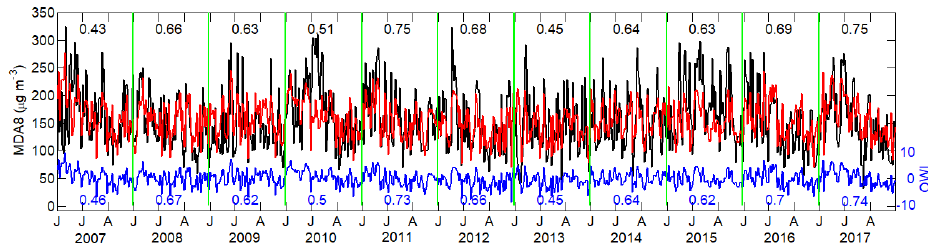
Figure 3. The variation in the daily observational SDZ MDA8 (black), fitting SDZ MDA8 (red), and OWI (blue) from June to August during 2007–2017. The numbers are the correlation coefficients between the observational SDZ MDA8 and fitting SDZ MDA8 (red) and OWI (blue).